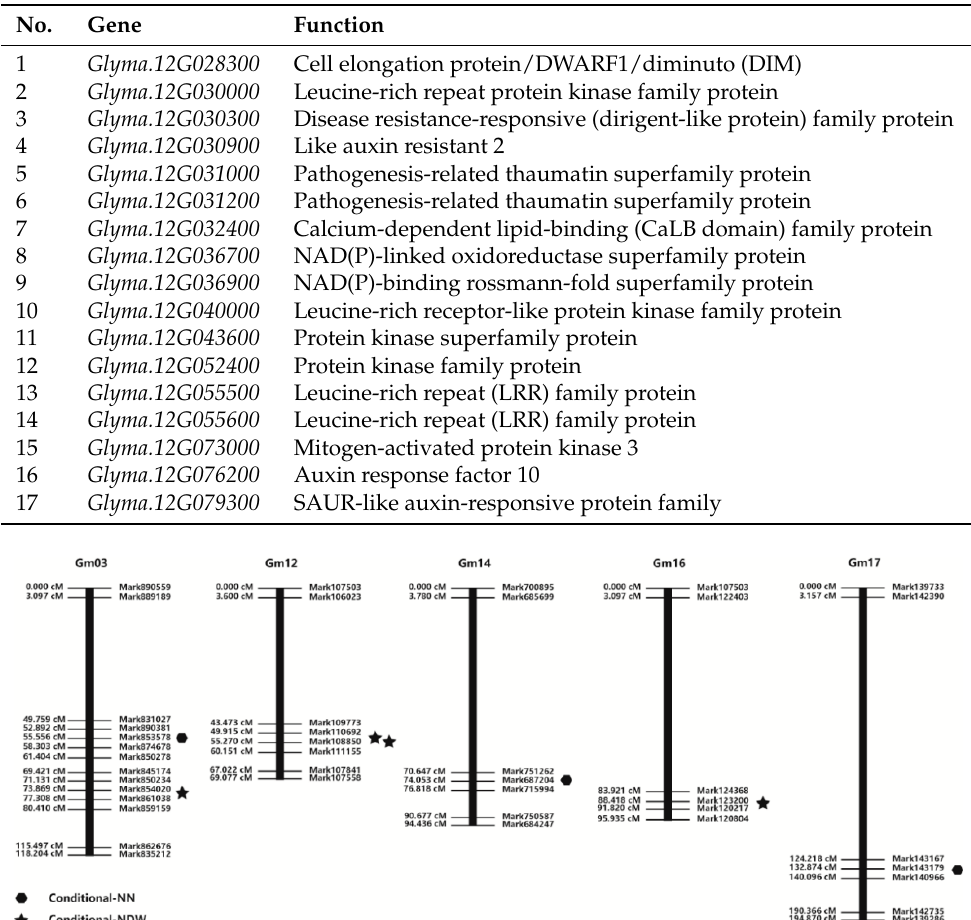
Table 2. Chromosomal localization of conditional QTLs for nodule-related traits.